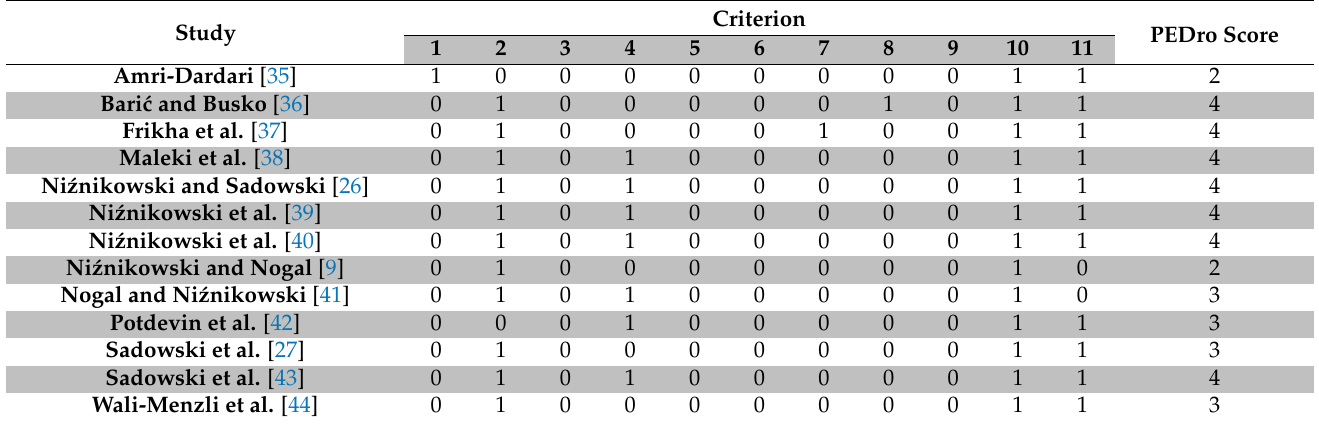
Table 1. PEDro quality rating scores